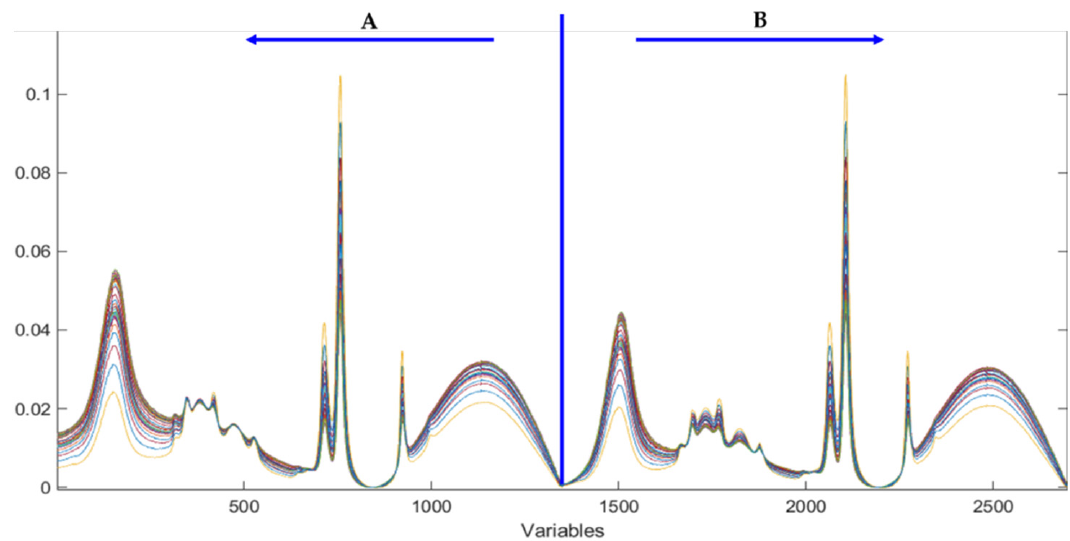
Figure 2. IR spectroscopic fused data of white Tequilas. Variables #1–1350 represent block A in which the base line was corrected in the same points for both TB and TBM classes. Variables #1351–2700 represent block B in which the baseline was corrected in different points according to each class (see Section 2.3 for details).